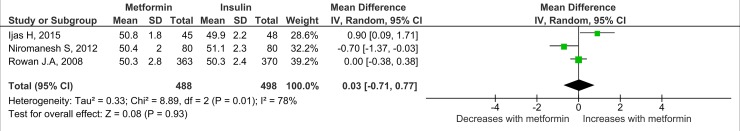
Neonatal height.Expressed as mean difference (random effects model) and 95% CI. IV, mean difference.